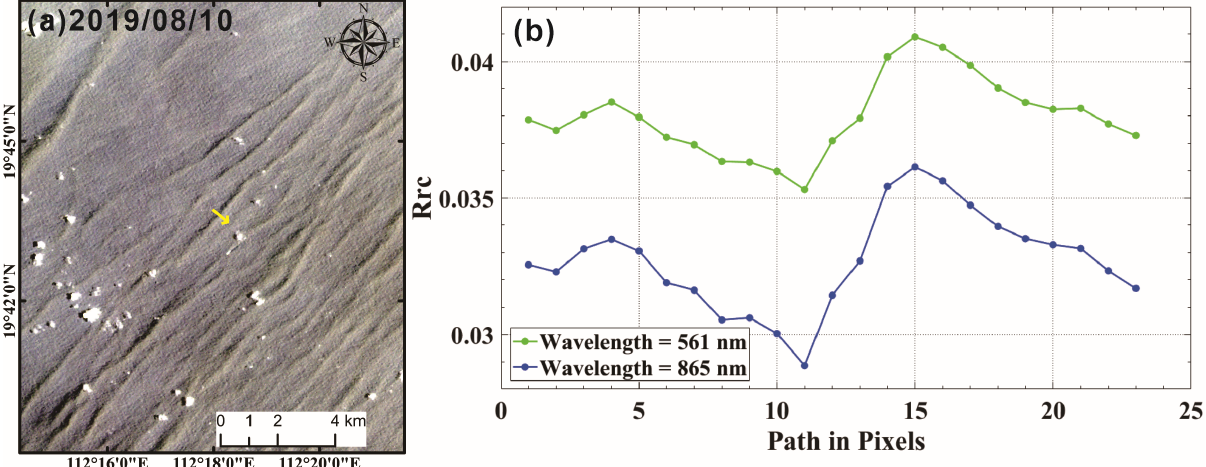
Figure 5. ( a ) Internal wave presented as alternating bands of light and dark strips; ( b ) Rrc reflectance at 561-nm and 865-nm bands along the transect marked in panel a (yellow arrow). Floating algae of various forms could resample oil slicks in optical imagery [35].